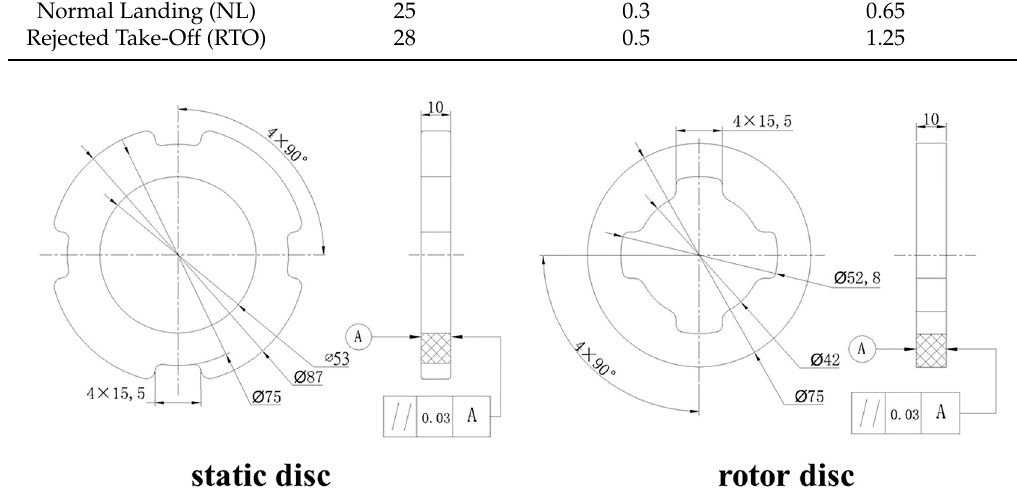
Figure 2. Schematics of the composites brake discs (unit: mm).